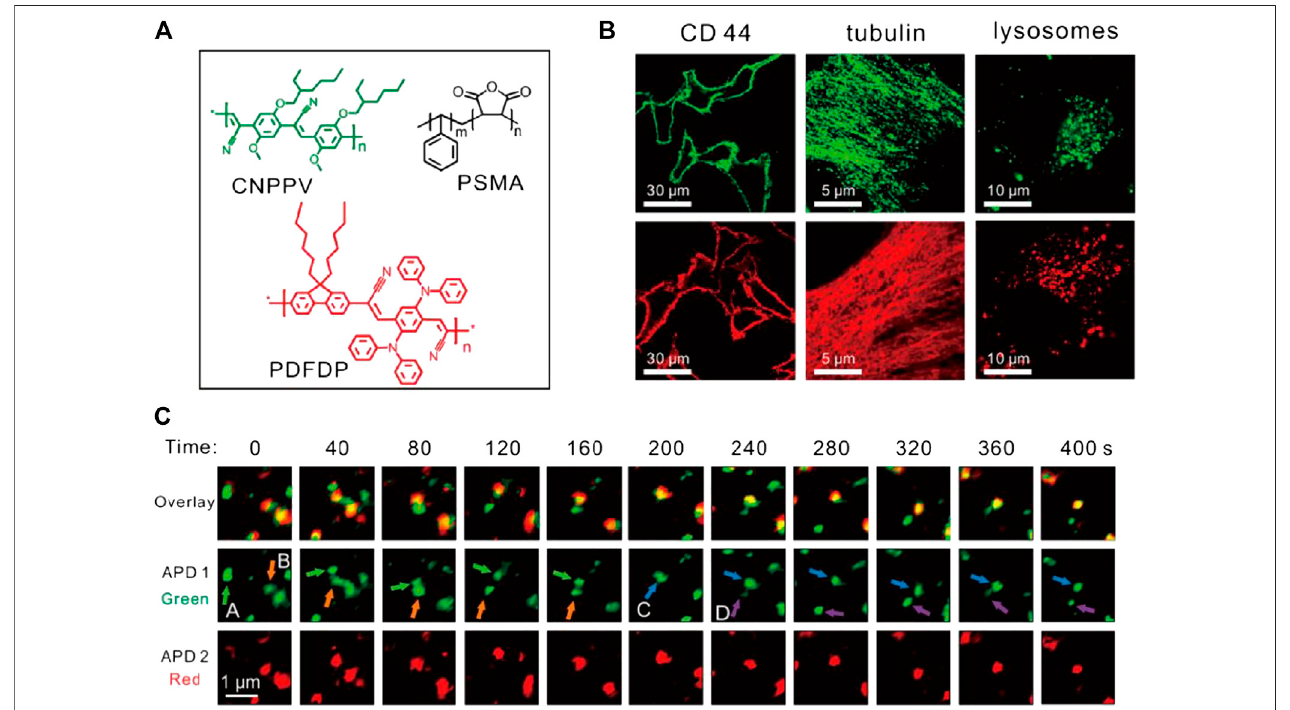
FIGURE 5 | Bioconjugated PDotsfor STED imaging (Wu et al., 2020). (A) Chemical composition of two PDots. (B) STED imaging ofsubcellular structures bonded with PDots through immuno fl uorescence labeling. (C) Application of PDots for real-time tracking of organelle interactions.